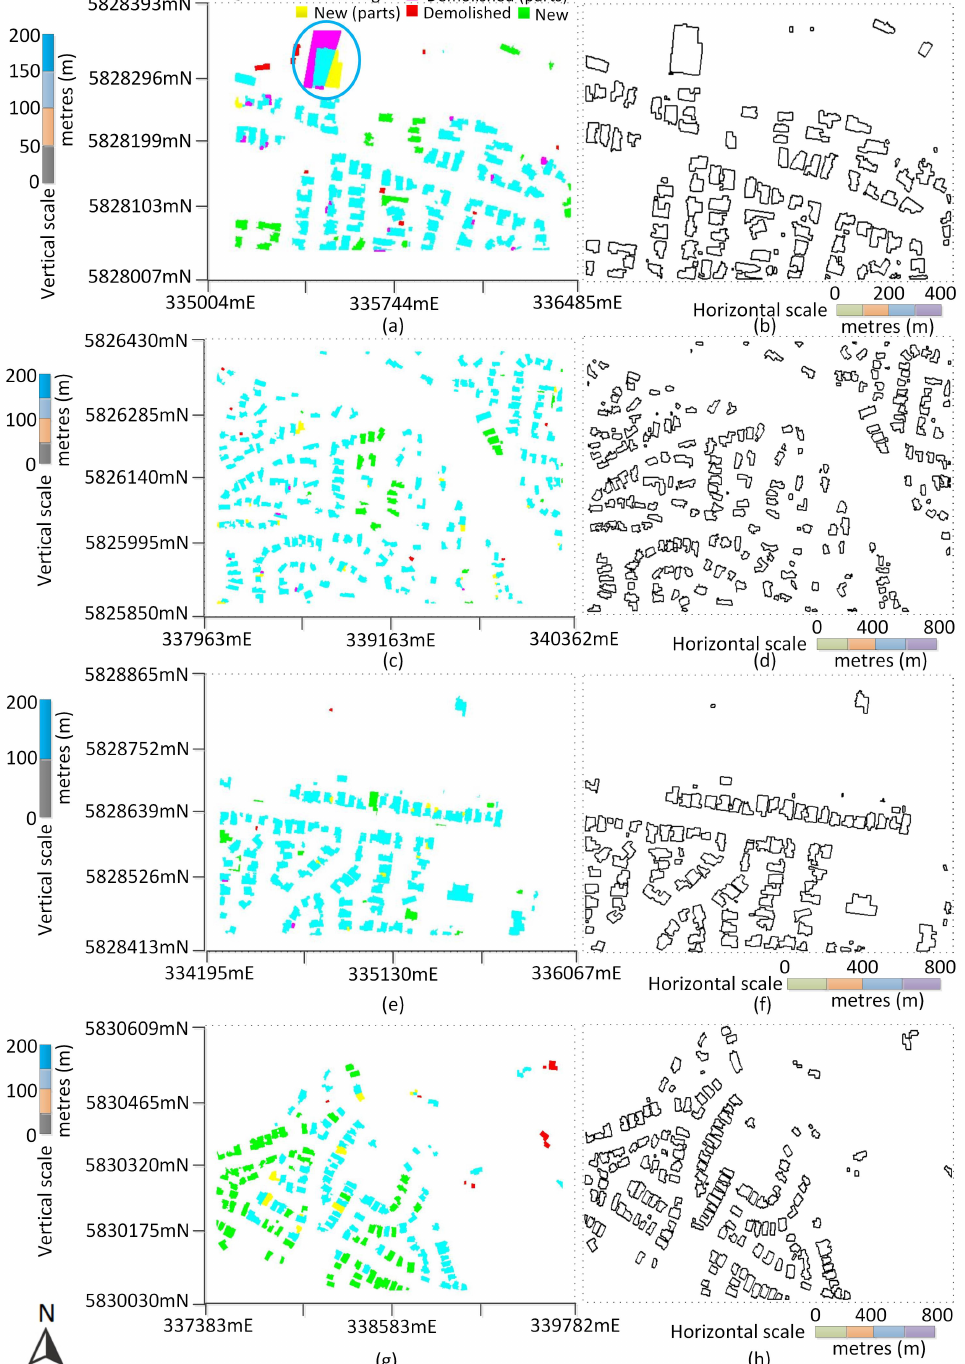
Figure 9. Left column: automatic change detection outcome. Right column: updated building maps using the GUI from existing maps and change detection outcome. ( a , b ) Scene 1, ( c , d ) Scene 2, ( e , f ) Scene 3, and ( g , h ) Scene 4. The coordinate (easting (E), northing (N)) and scales shown in ( a ), ( c ), ( e ) and ( g ) are applicable to ( b ), ( d ), ( f ) and ( h ),